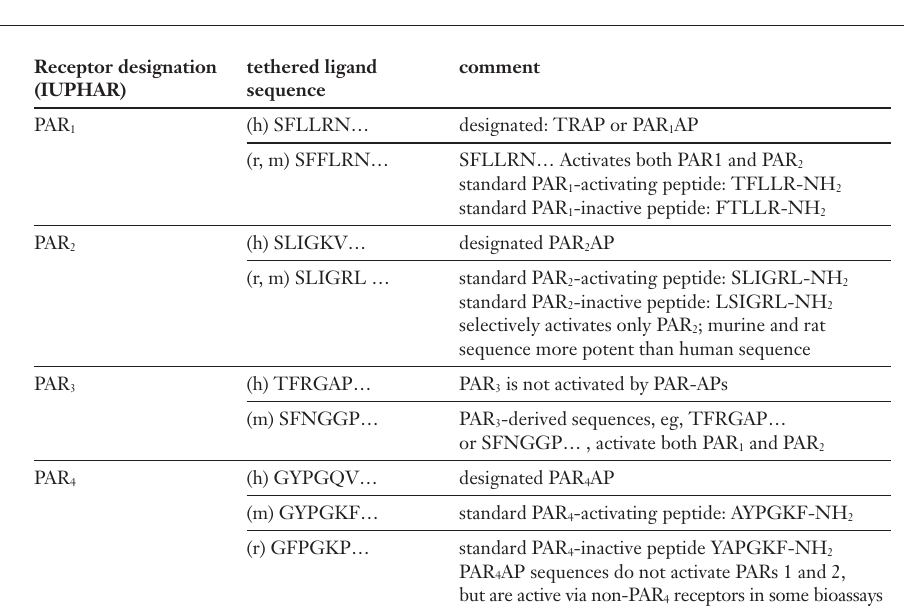
Mechanism of activa- tion of Proteinase- Activated Receptors, as typified by human PAR 4 . The figure illus- trates the activation of human PAR 4 both by the tethered lig- and mechanism trig- gered by thrombin or trypsin (left and cen- tre) and by a PAR 4 -ac- tivating peptide (GYPGQV-NH 2 ) with a sequence based on the proteolytically- revealed tethered ligand